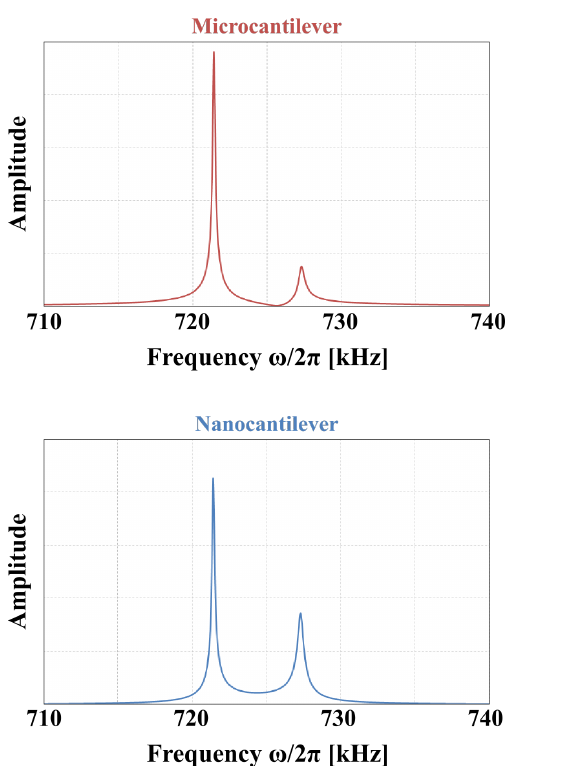
Figure 19. Amplitude curves for both cantilevers for the first bend- ing mode obtained with the discrete beam model in Fig.